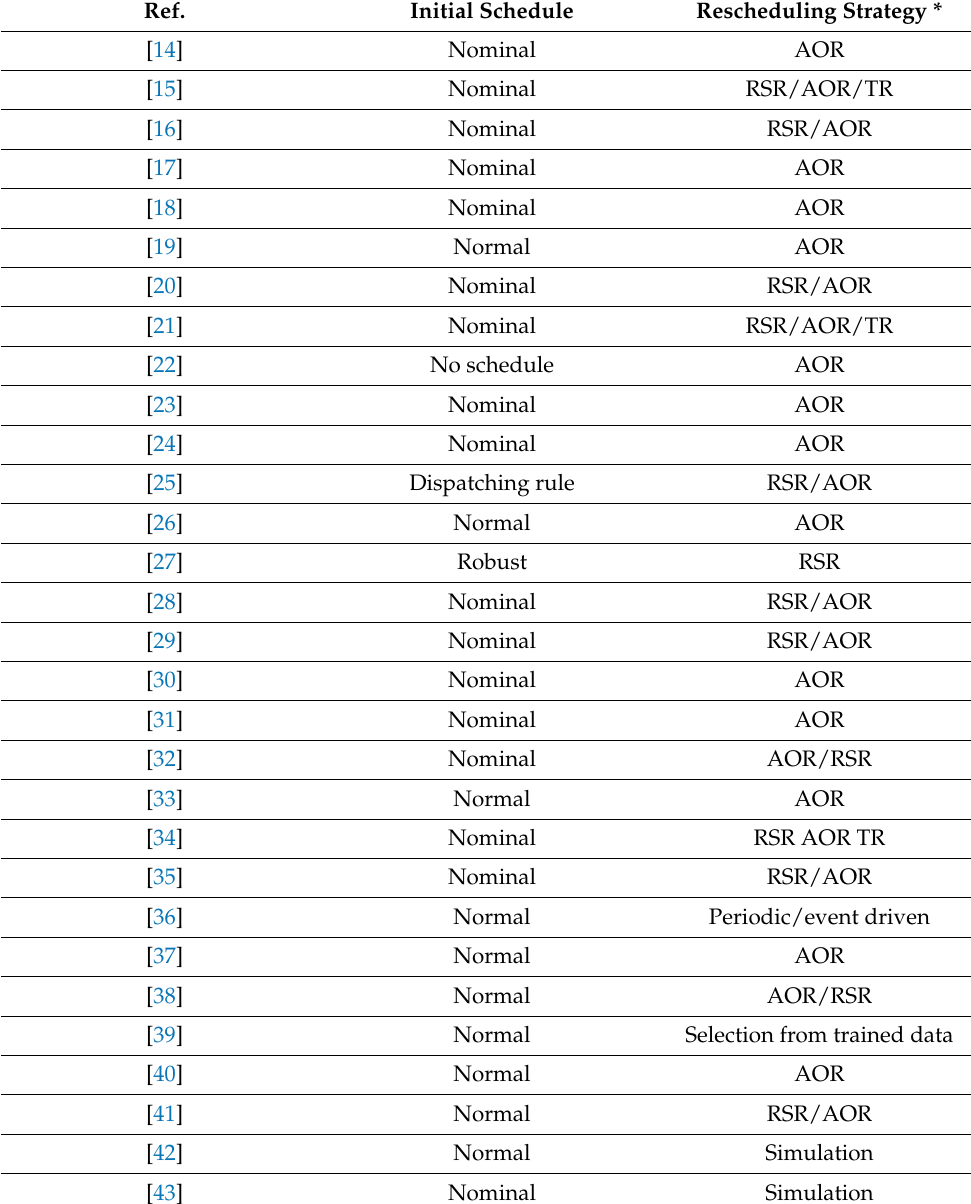
Table 1. Initial Schedule and Rescheduling Strategies.